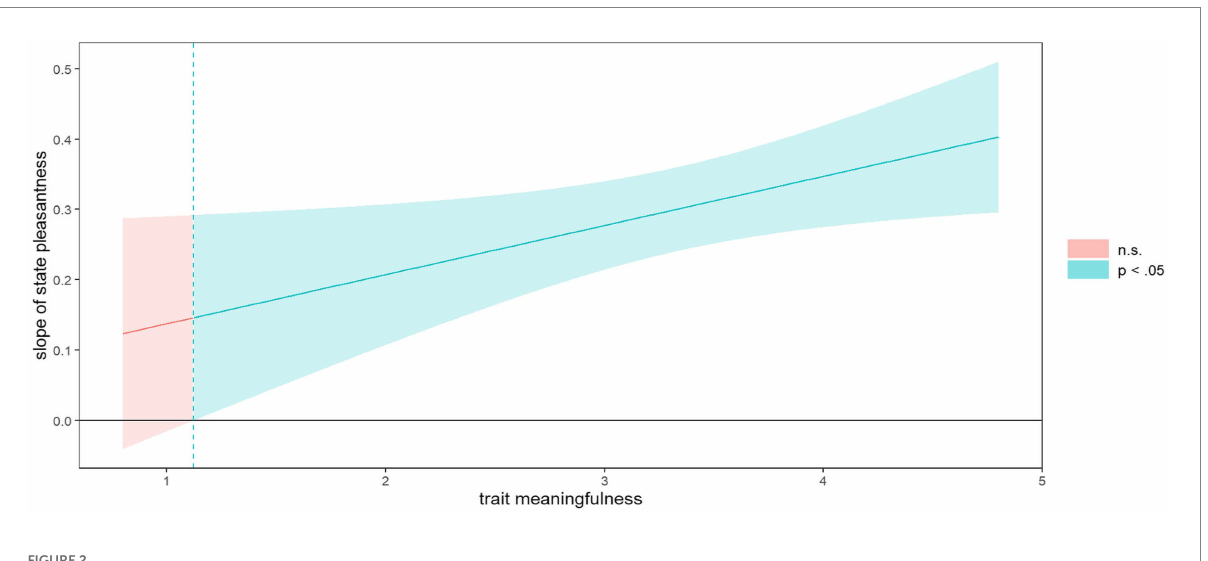
FIGURE 2 Johnson Neyman plot of interaction trait meaningfulness and state pleasantness.